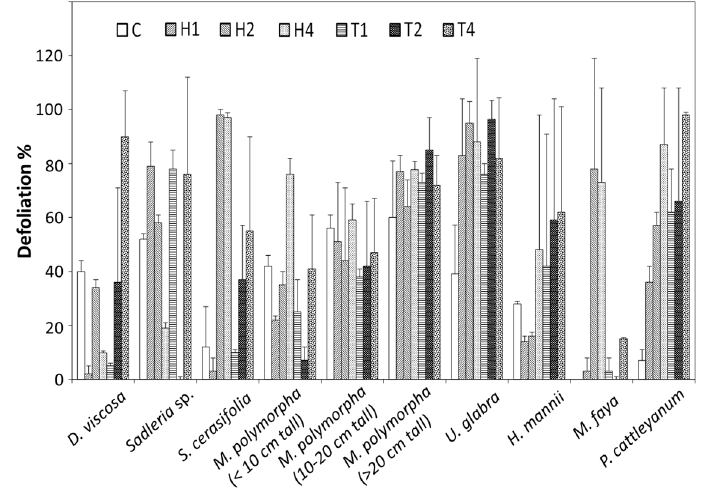
Figure 2. Defoliation of the forest plants by hexazinone and tebuthiuron at Kalalau Rim Site, 12 MAT. The plant species were aalii ( Dodonaea viscosa ) (native), amau ( Sadleria sp.) (native), naupaka ( Scaevola cerasifolia ) (native), ohia lehua ( Metrosideros polymorpha ) (native), hona ( Urera glabra ) (native), pilo ( Hedyotis mannii ) (native), faya tree ( Myrica faya ) (non-native), and strawberry guava ( Psidium cattleyanum ) (non-native). C (control, no hexazinone and tebuthiuron), H1 (hexazinone 1 kg ha − 1 ), H2 (hexazinone 2 kg ha − 1 ), H4 (hexazinone 4 kg ha − 1 ), T1 (tebuthiuron 1 kg ha − 1 ), T2 (tebuthiuron 2 kg ha − 1 ) and T4 (tebuthiuron 4 kg ha − 1 ).